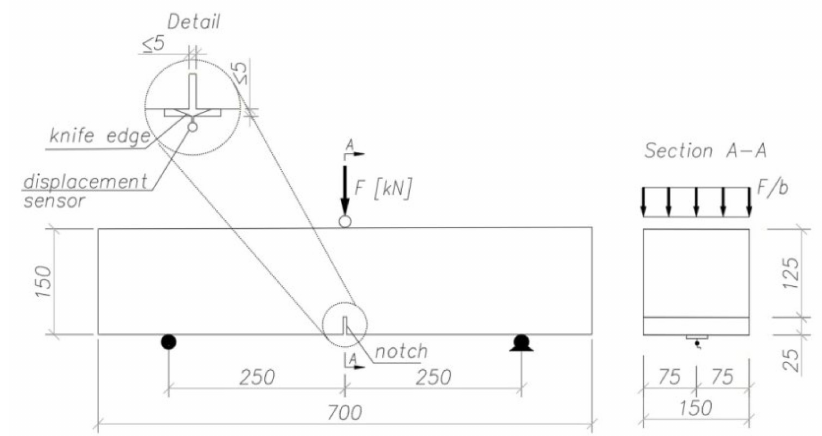
Figure 2. Scheme of the beam load during the testing of the residual strength of the fiber composite